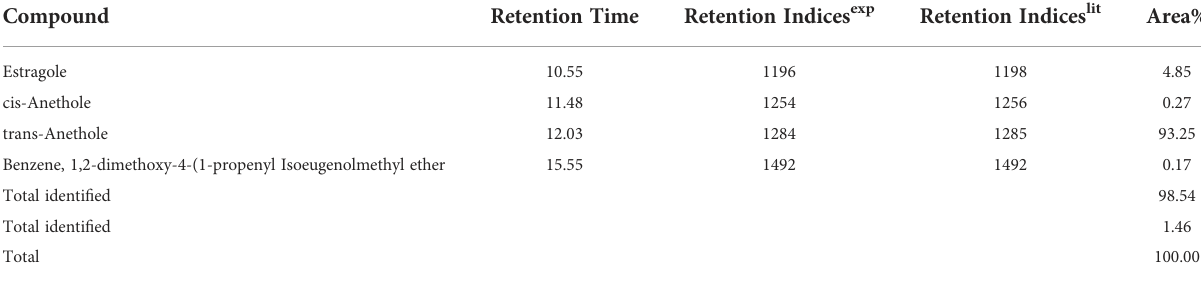
TABLE 4 GC-MS analysis of anethole rich variety of C. heptaphylla (Jor Lab CH-2) leaf essential oil planted at Madang location. Compound